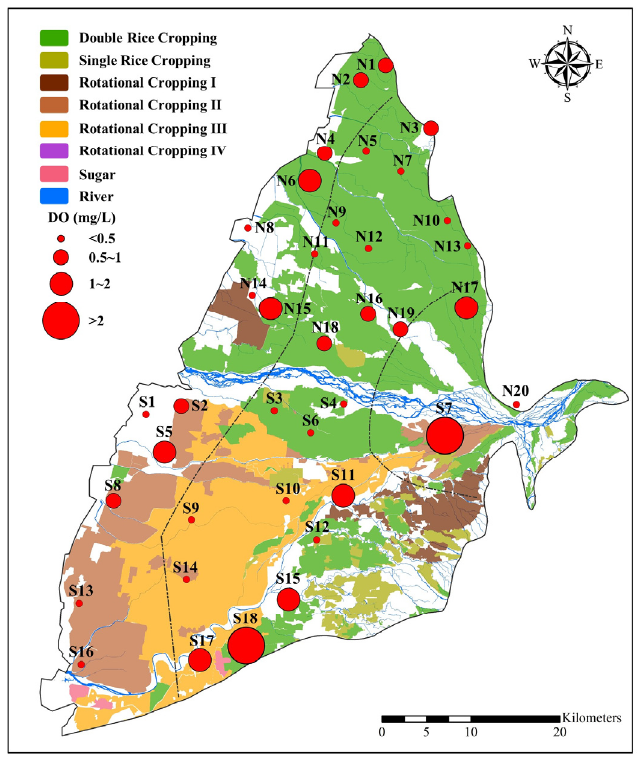
Figure 11. Spatial distribution of DO in different concentration ranges for all observation wells under various cropping patterns.